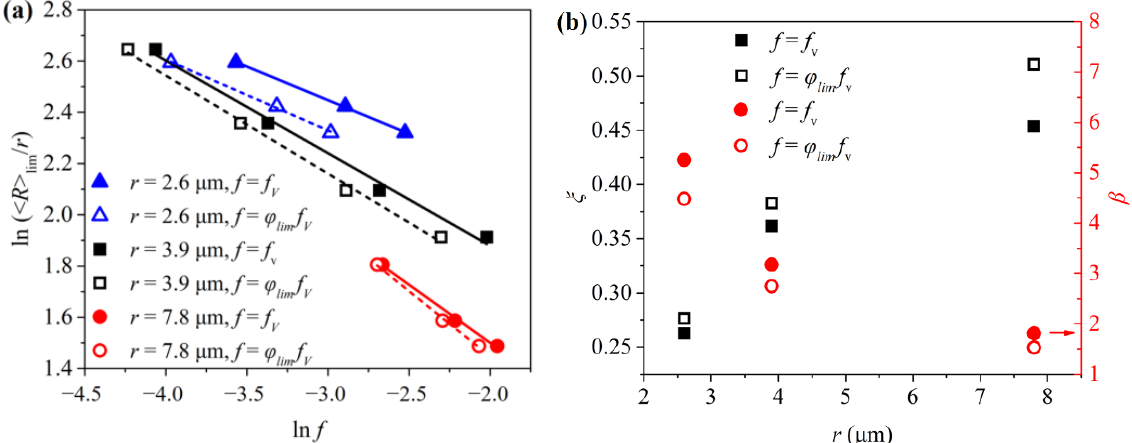
Figure 7. The comparisons between the present simulation results and the Zener’s and the modified Zenner’s pinning theories. ( a ) The fitting results for Equations (13) and (14); ( b ) values of ξ and β for different particle radii.